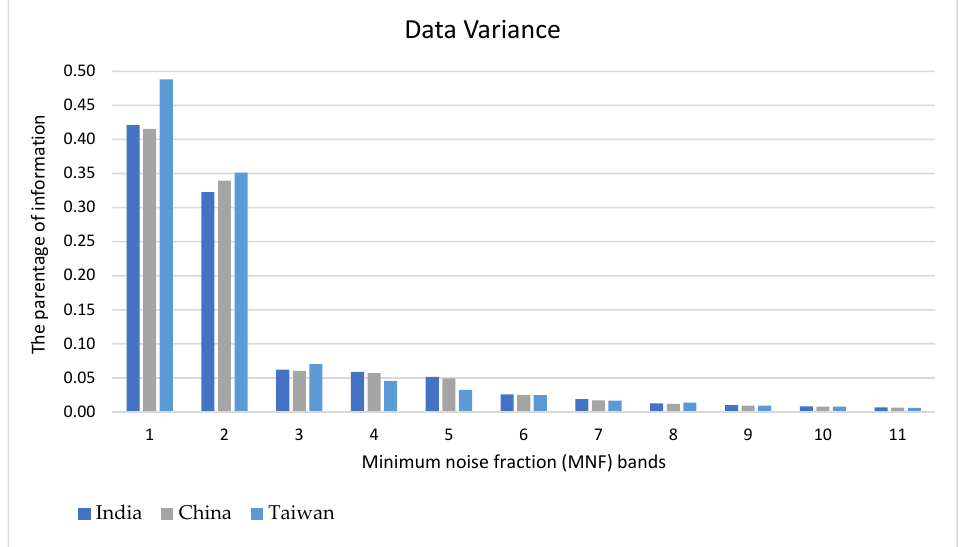
Figure 4. Visual illustration of the MNF bands’ data variance for the satellite images of each case study. Y -axes on the left and right sides of the graph show the parentage of information in each MNF band, and X -axis is the MNF bands.